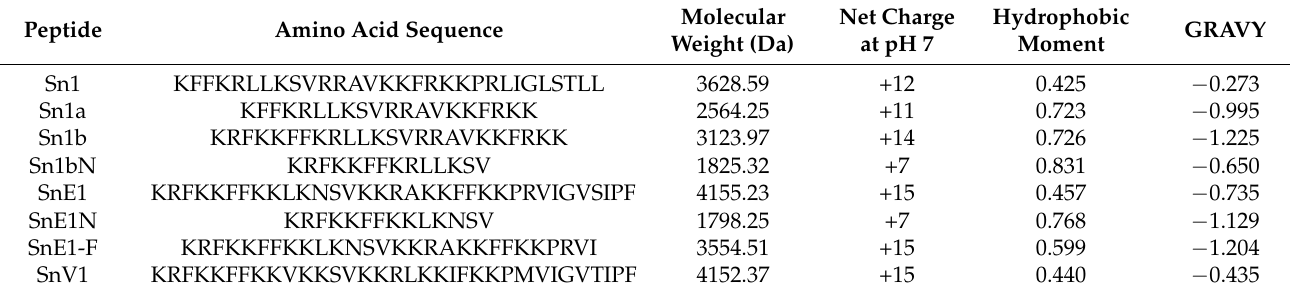
Table 1. Predicted physiochemical properties of all peptides utilised in this study. Physiochemical properties of the peptides were predicted using ExPASy Bioinformatics Resource Portal Protparam software available at https://web.expasy.org/ protparam/ (accessed on 26 July